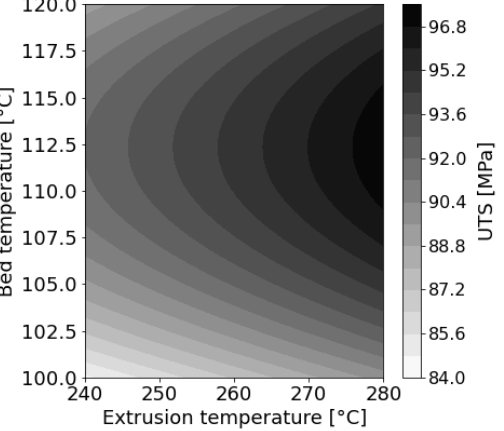
Figure A8. Contour plot for T ext and h according to the ML-based prediction model.